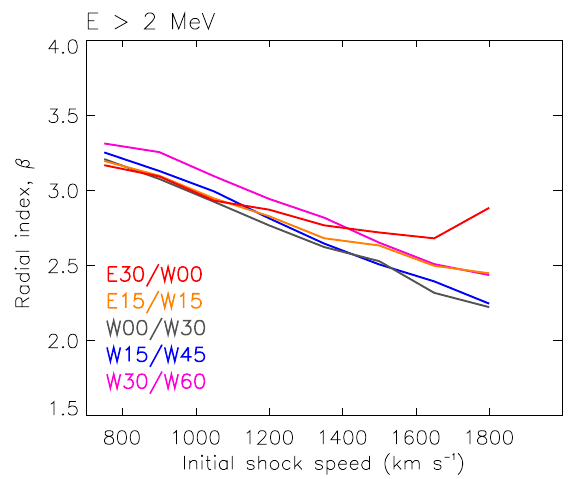
Fig. 6. Radial index (for E > 2MeV, see text) plotted as a function of the initial shock speed. Each line represents one pair of SEP events at 0.4 AU and at 1.0 AU which, approximately, share the same IMF